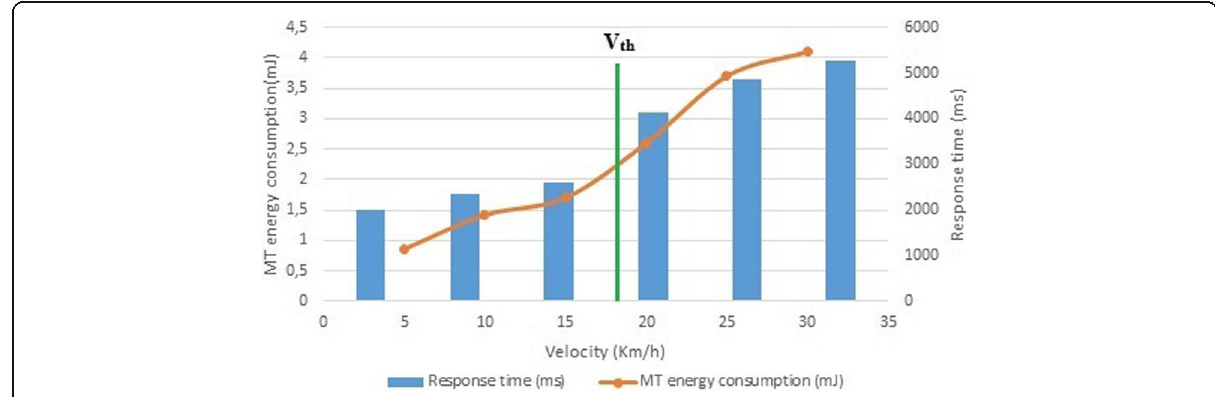
Fig. 6 QoS with different users speed